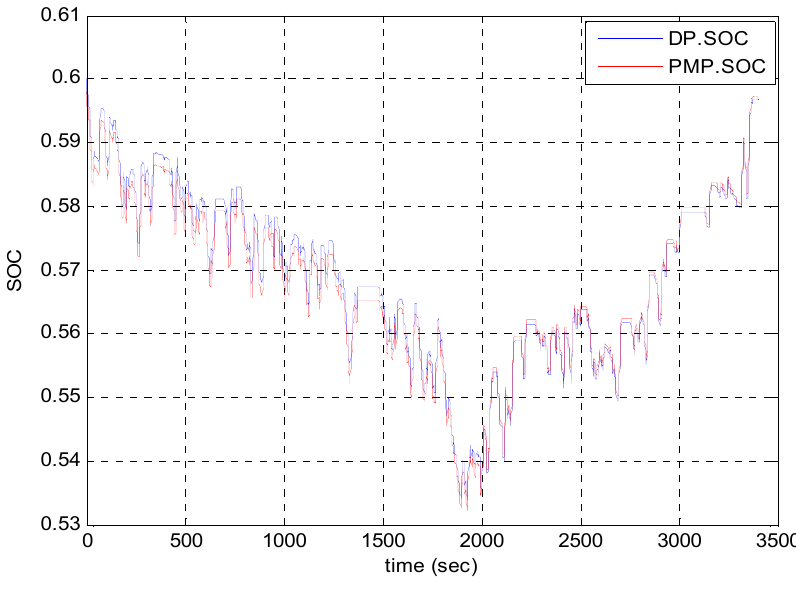
Figure 5. SOC curves of DP and PMP.